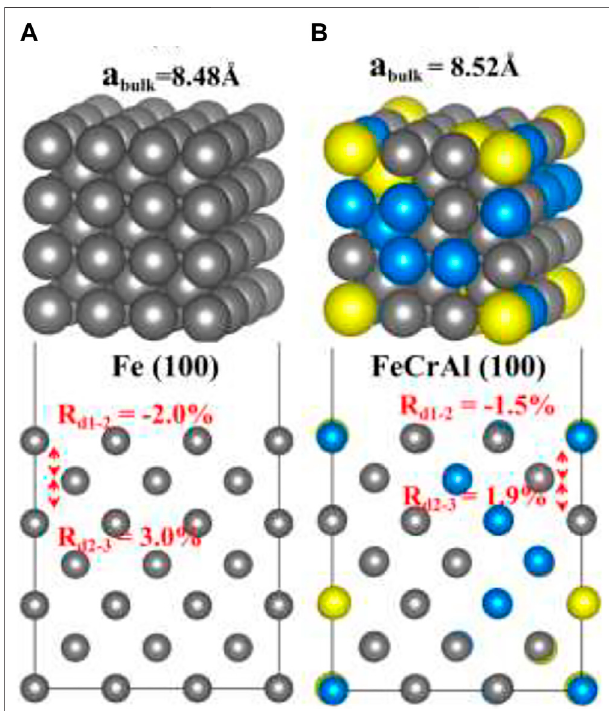
FIGURE 1 | The optimized structures of Fe and FeCrAl: (A) bulk and (100) slab of Fe; (B) bulk and (100) slab ofFeCrAl (hereinafter dark grey atoms are Fe, blue atoms are Cr, and yellow atoms are Al).